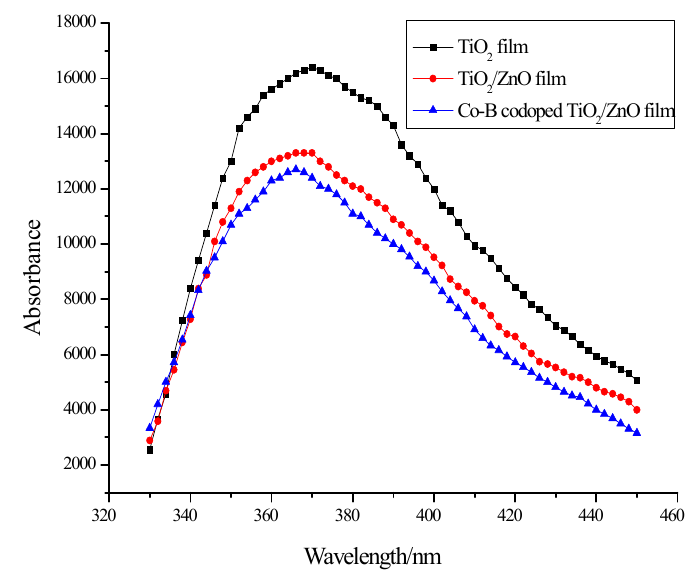
Figure 6. PL spectra of pure TiO 2 , composite TiO 2 /ZnO, and Co-B codoped TiO 2 /ZnO films.